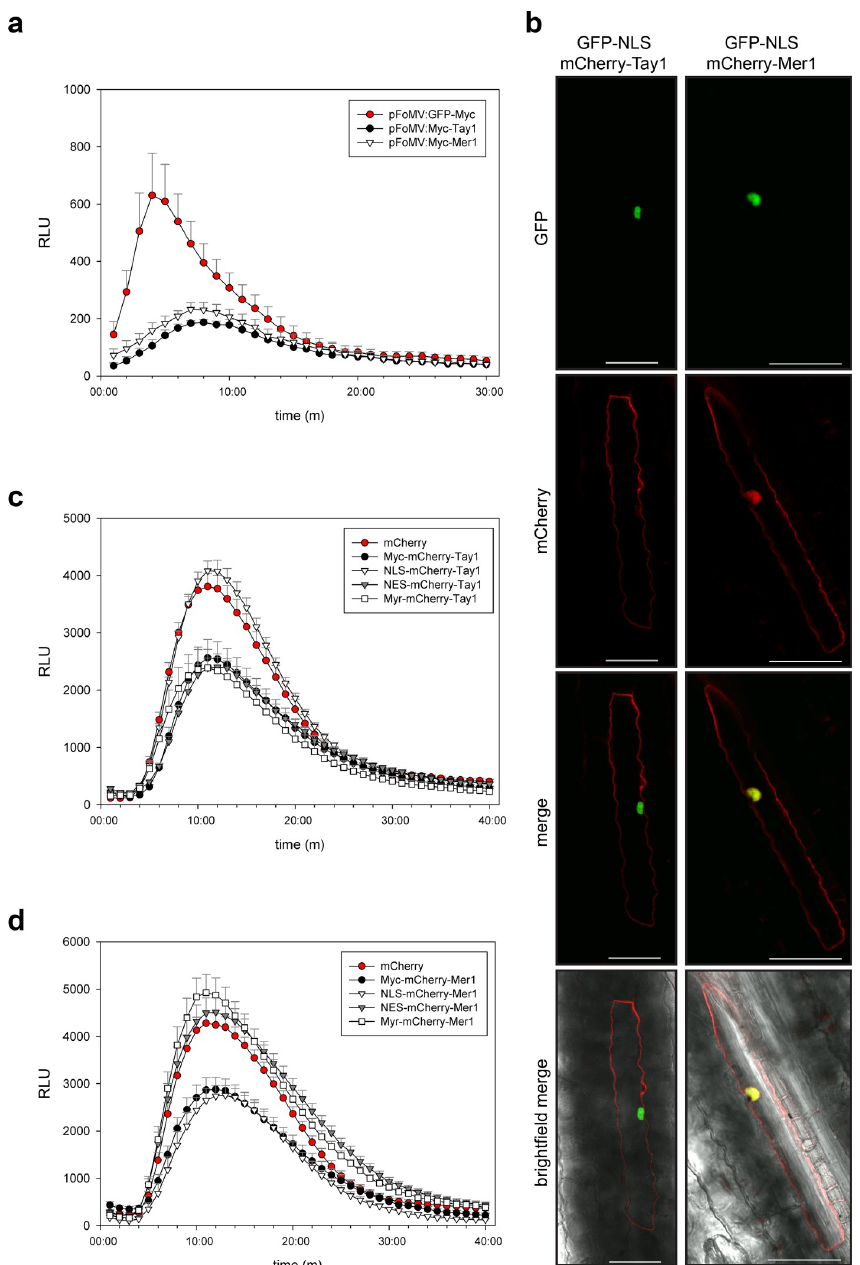
Fig 3. Tay1 and Mer1 are functional in maize and target different cell compartments. a. PAMP-triggered ROS burst in maize. Transient expression of Tay1 28-398 and Mer1 23-341 in maize with the viral vector pFoMV leads to reduction of the oxidative burst triggered by flg22. b. Expression of mCherry- Tay1 28-398 and mCherry- Mer1 23-341 in maize epidermal cells by biolistic bombardment. mCherry-Tay1 28-398 (left panels) localizes preferentially to the cytoplasm whereas mCherry-Mer1 23-341 (right panels) localizes to the cytoplasm and nucleus. GFP-NLS was co- expressed as a nuclear marker. Scale bar = 50 μ m. c. d. Sub-cellular localization affects the ROS burst inhibiting activity of Tay1 and Mer1 differentially. Plants expressing mCherry were used as reference control showing maximum ROS- burst and plants expressing Myc-mCherry-Tay1 28-398 (c) or Myc-mCherry-Mer1 23-341 (d) were used to monitor their intrinsic ROS-burst inhibitory activity without miss localization. Curves show flg22-triggered ROS burst over 40 minutes. c. Removing Tay1 from the nucleus (NES-mCherry-Tay1 28-398 or Myr-mCherry-Tay1 28-398 ) does not affect its inhibitory activity, whereas targeting Tay1 to the nucleus (NLS-mCherry-Tay1 28-398 ) abolishes its inhibitory activity. d. Removing Mer1 from the nucleus (NES-mCherry-Mer1 23-341 or Myr-mCherry-Mer1 23-341 ) abolishes its inhibitory activity, whereas targeting Mer1 to the nucleus (NLS- mCherry-Mer1 23-341 ) does not modify its